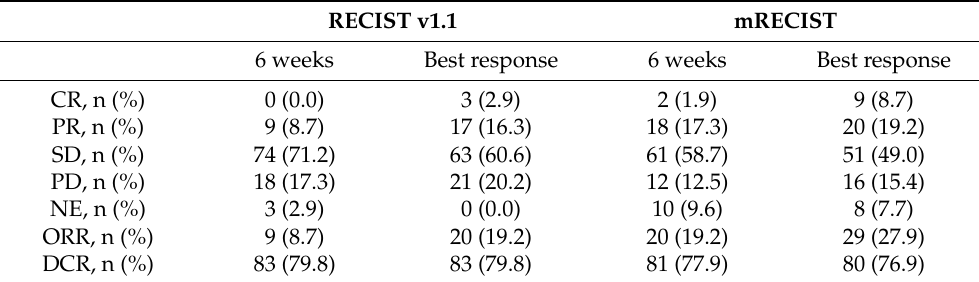
Table 2. Table 2. Comparison of progression-free survival in each subgroup.